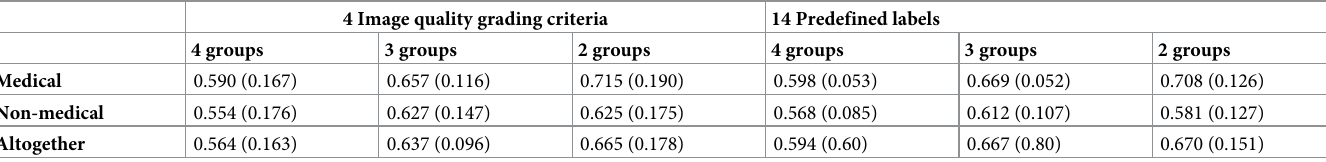
Table 3. Inter-rater agreement in the two setups with different image quality category groups. Cohens’s weighted kappa was calculated for the grading using 4 image quality categories (Excellent (E)/ Good (G)/ Adequate (A)/ Insufficient (I)) and for the second round of grading using 14 labels. In the latter, the same 4 categories were compiled as in the first round of grading (E/G/A/I). Cohens’s weighted kappa was also determined with E and G merged for both grading rounds [(E+G)/A/I]. To assess the agreement when distinguishing between poor quality images both in the first and second round, Cohen’s weighted kappa was calculated with two merged groups (E and G vs. A and I). The kappa values are presented as medians (interquartile range) for all the graders and for both groups (medical,